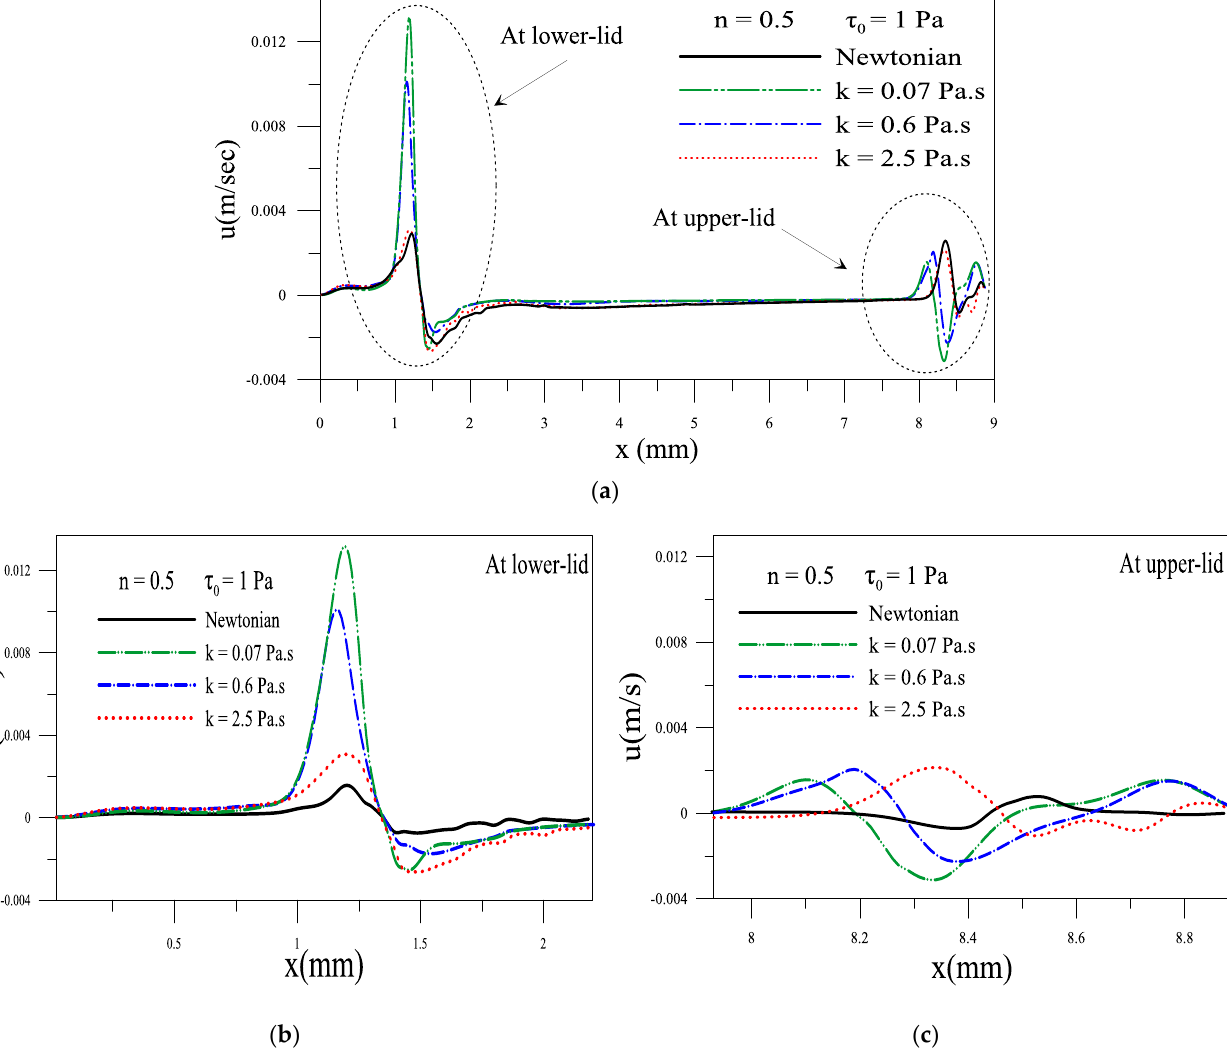
Figure 6. Depth average velocity for different consistency k, at time = 0.18 s. ( a ) over the whole cornea surface ( b ) and ( c ) a closeup near the lower and upper eyelid.